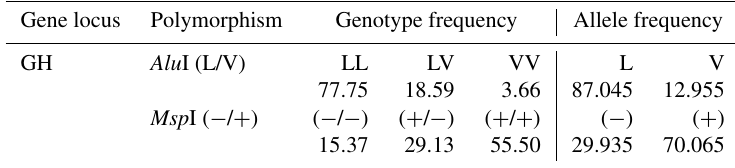
Table 3. Genotypic and allelic frequencies (%) in the GH- Alu I and GH- Msp I polymorphisms. Gene locus Polymorphism